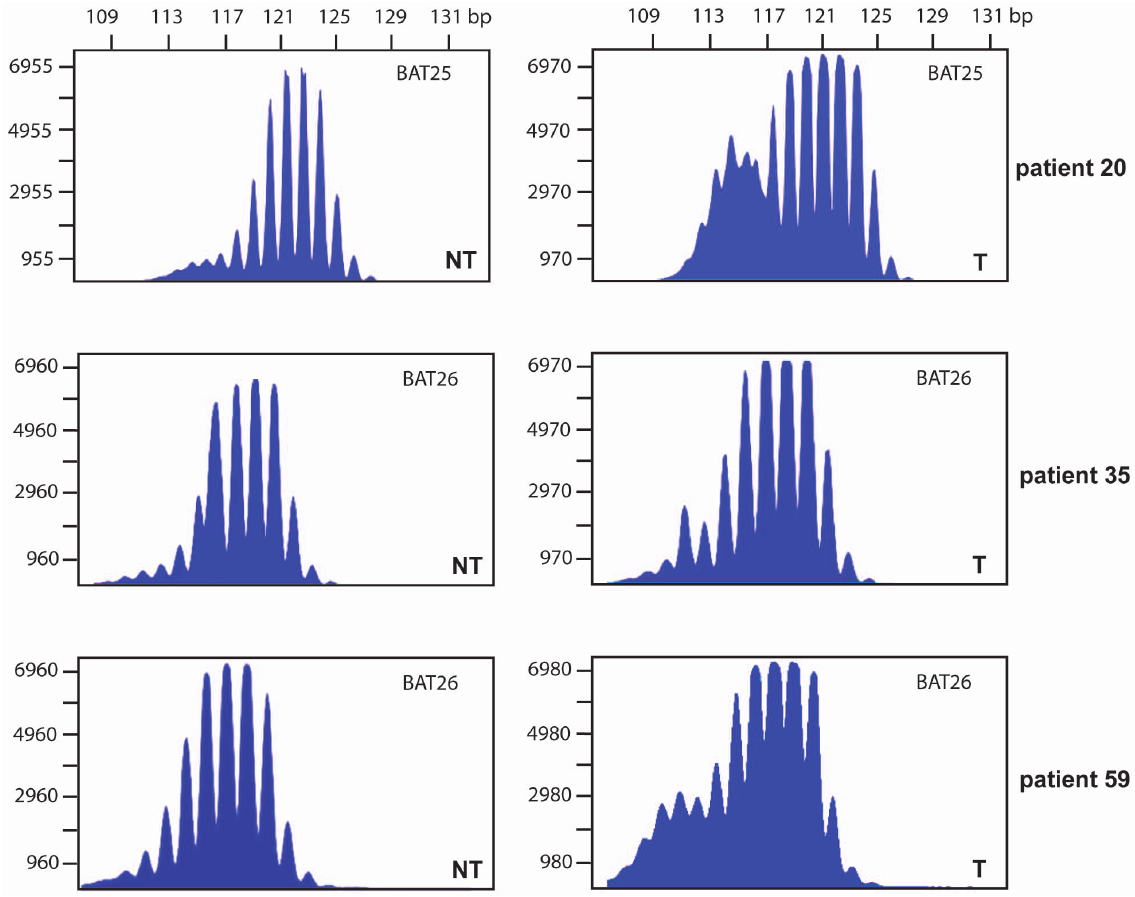
Figure 3. MSI analysis. Analysis of commonly used mononucleotide MSI marker loci BAT25 and BAT26 was performed in all patients showing promoter methylation in one of the tested MMR genes. Three examples are shown here. (T) HCC tissue, (NT) non-tumour adjacent tissue.